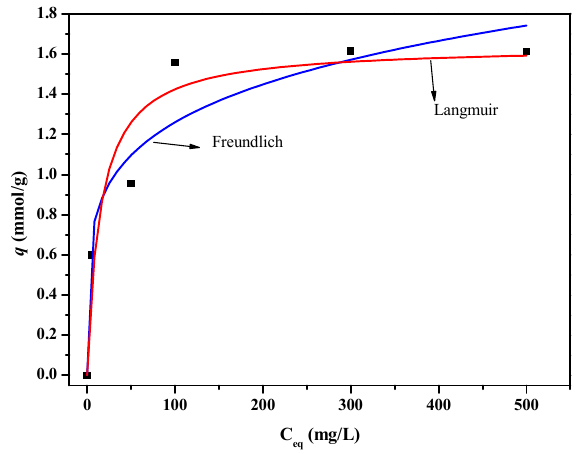
Figure 11. Boron adsorption isotherms of PSF-diol membrane.